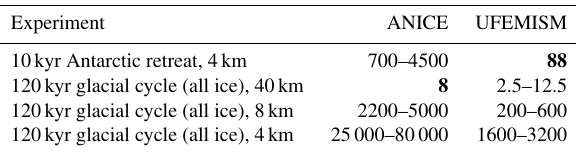
Figure 13. Number of vertices vs. ice-margin resolution for Green- land and Antarctica. Table 3. Observed and extrapolated computation times (in core hours) for different simulations with ANICE and UFEMISM. Bold- faced numbers are observed times, all others are estimates based on